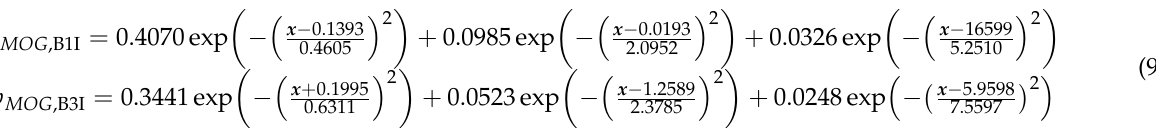
Figure 10. The fitting envelop curve of the cycle-slips histogram with the mixture of Gaussian distribution.